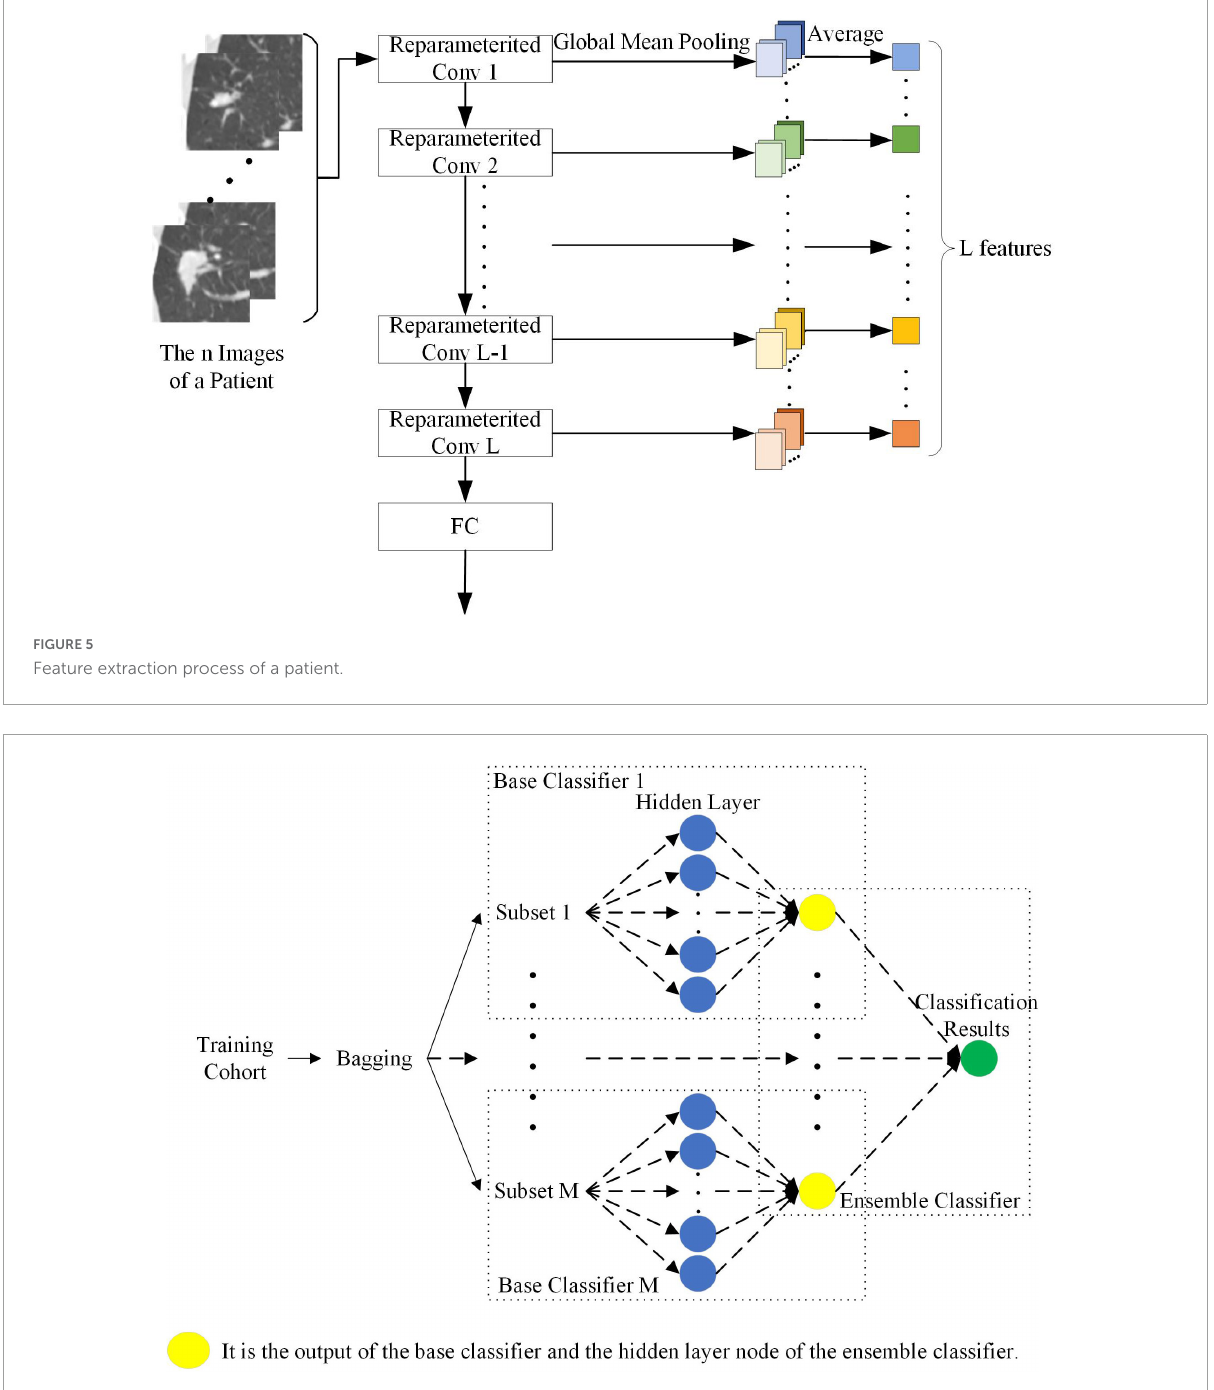
FIGURE6 Ensemble classifier based on Sparse Bayes ELM.